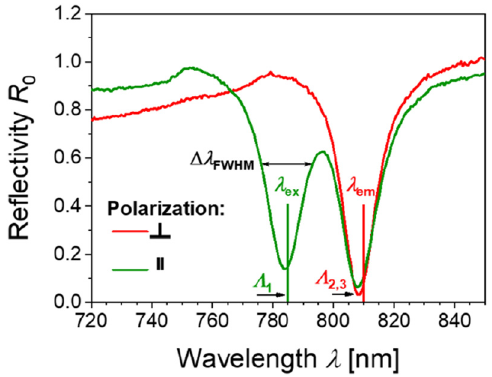
Figure 3: Plasmonic modes. Zero-order reflectivity spectrum measured for the normally incident beam at the MPG surface brought in contact with water ( n s =